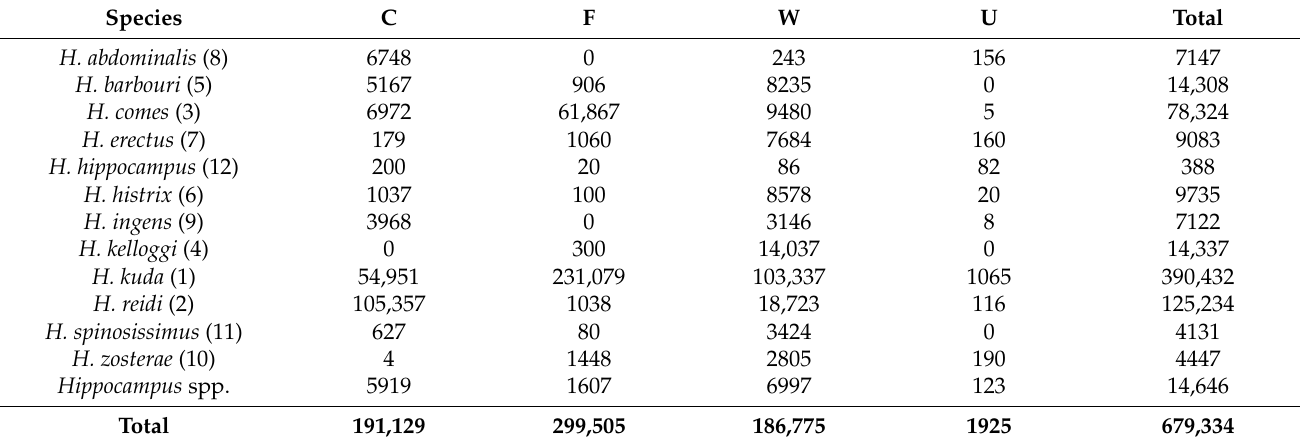
Table 3. Import numbers (individuals) of the most live-traded Hippocampus species worldwide over 2004–2018 [69] (ranking 1 to 12). Hippocampus spp. = other species and unidentified. Source: C = captive-bred, F = born in captivity, W = wild-caught, U = unknown and unmentioned. Re-exports are excluded.